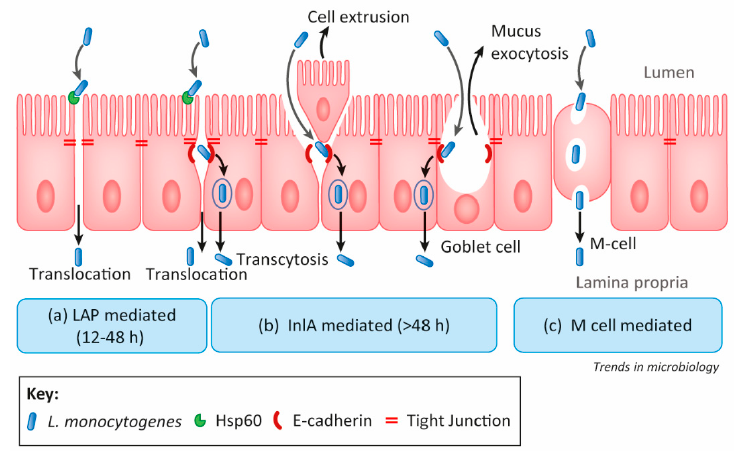
Figure 2. Listeria monocytogenes translocation pathways from lumen to lamina propria in the intestine. Figure adapted with permission from Drolia and Bhunia 2019 [47]. Copyright, Elsevier. (b) In the InlA-mediated pathway, surface-expressed InlA anchored to the pepti- doglycan interacts with host receptor E-cadherin and promotes transcytosis [52]. Alt- hough E-cadherin is one of the cell-to-cell junction proteins located at adherens junctions between epithelial cells, they could be accessible to L. monocytogenes in the lumen when cell extrusion or mucus exocytosis creates a transient opening [47,53]. The binding of InlA to E-cadherin (located at the adherence junction) triggers a local cytoskeletal protein rear- rangement to trap L. monocytogenes into a vacuole followed by cytoplasmic inhabitation for cell-to-cell movement [46]. Though InlA is an important virulence factor, it does not appear to participate in biofilm formation, its expression has been significantly dimin- ished in sessile cells [54]. (c) In the M-cell pathway, L. monocytogenes are passively transported by microfold cells (or M cells) in the Peyer’s patch during sampling of luminal antigens [55]. Internalin B, an invasion protein also enhances M-cell-mediated translocation [56] while its direct involvement in intestinal epithelial cell invasion remains controversial [57,58]. After crossing the intestinal barrier, L. monocytogenes systemically disseminate to ex- traintestinal organs, including the spleen, liver, mesenteric lymph node, gall bladder, brain, and placenta in pregnant women [46]. The special strategy of its dissemination is to hide in the cell cytosol and spread to adjacent cells without being exposed to the extracel- lular environment. Inside the host cell vacuole, L. monocytogenes expresses a pore-forming toxin, Listeriolysin O (LLO) (encoded by hly ), and bacterial phospholipases, PlcA and PlcB to escape from the vacuole. LLO oligomerizes into “arc- or slit-shaped” assemblies in the membrane to lyse the vacuole and facilitate L. monocytogenes to escape by the inactivation of phagocyte NOX2 (NADPH oxidase), which produces reactive oxygen species as an an- timicrobial strategy [59,60]. Besides, phosphatidylinositol-specific phospholipase C (PI- PLC) and phosphatidylcholine-specific phospholipase (PC-PLC) are also expressed by L. monocytogenes in the endocytic vacuole to facilitate escape from the phagosome. The bacte- rium can also survive in the vacuole for an extended period, causing latent infection [61]. In addition, L. monocytogenes also suppresses the cellular proinflammatory response using internalin C (InlC) and moves from cell-to-cell by polymerizing host actin protein (ActA) [62,63]. This triggers host cell cytoskeletal rearrangement and polymerization to propel cell movement towards the host cell membrane [64]. ActA together with PLC helps to avoid autophagy [65,66] by stalling autophagosomal structures [67].